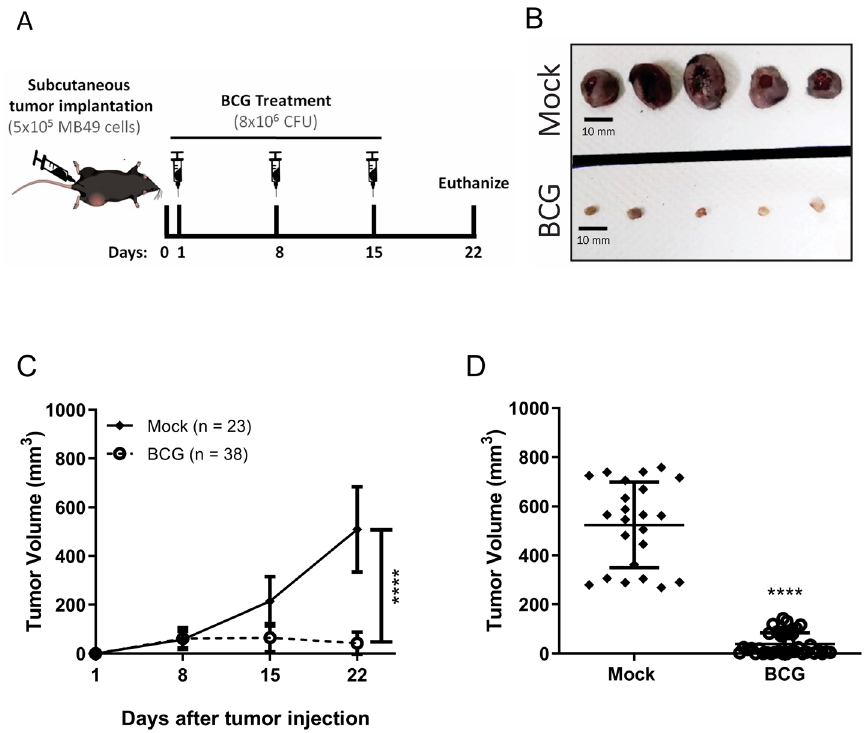
Figure 1. BCG treatment in subcutaneous bladder tumor. ( A ) Scheme of the BCG treatment in a heterotopic (subcutaneous) syngeneic tumor model with MB49 bladder tumor cells in female C57BL/6 mice. MB49 cells (5 × 10 5 cells) were subcutaneously injected on the right flank. After 24 h of tumor injection, mice received the first intratumoral treatment with BCG (8 × 10 6 CFU) or PBS (Mock). The treatments were performed every 7 days (total three doses) and the tumor volume was evaluated once a week using a digital caliper. Mice were euthanized and the tumors removed after 22 days post-tumor injection. ( B ) Representative image of the BCG or Mock treatment effect in subcutaneous bladder tumor (Scale bar, 10 mm). Tumor growth curves ( C ) and the final volumes after 22 days ( D ) are shown. Figures ( C ) and ( D ) represents the tumor volumes mean and standard deviation summary of C57BL/6 WT control animals from the following in vivo experiments comparing WT and KO mice. ****Statistically significant compared to mock, P ≤